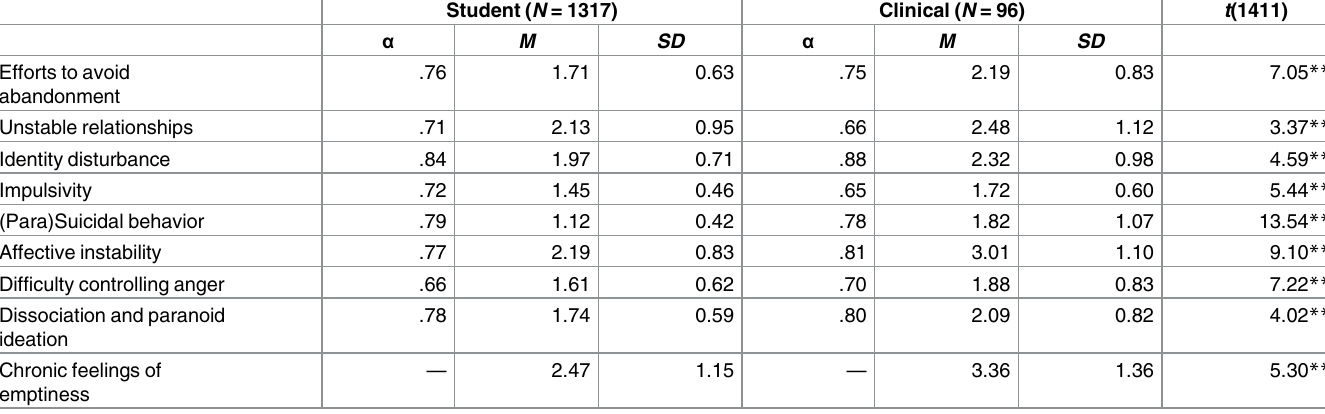
Table 2. Reliabilities and descriptive statistics of the nine BPDCL symptoms for the student and clinical samples (and difference between the two